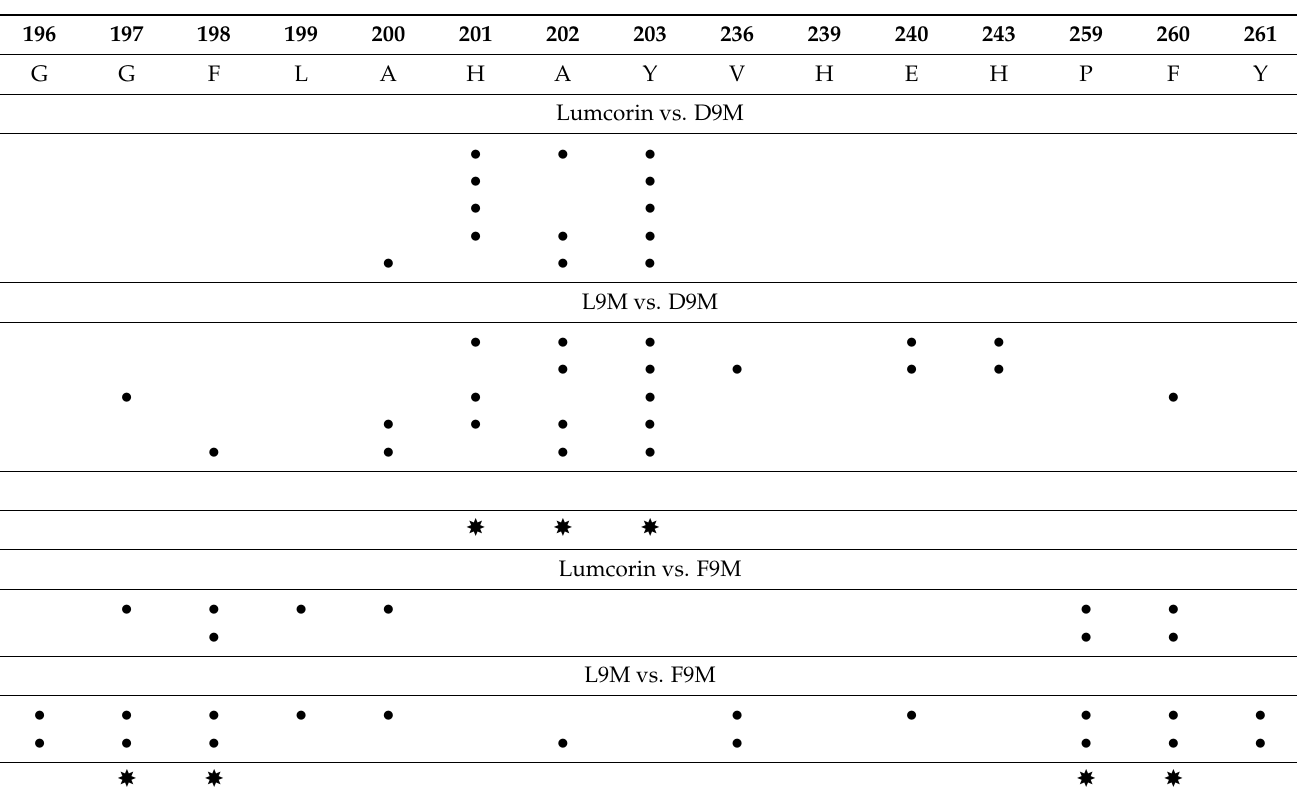
Table 4. Summary of the training test.